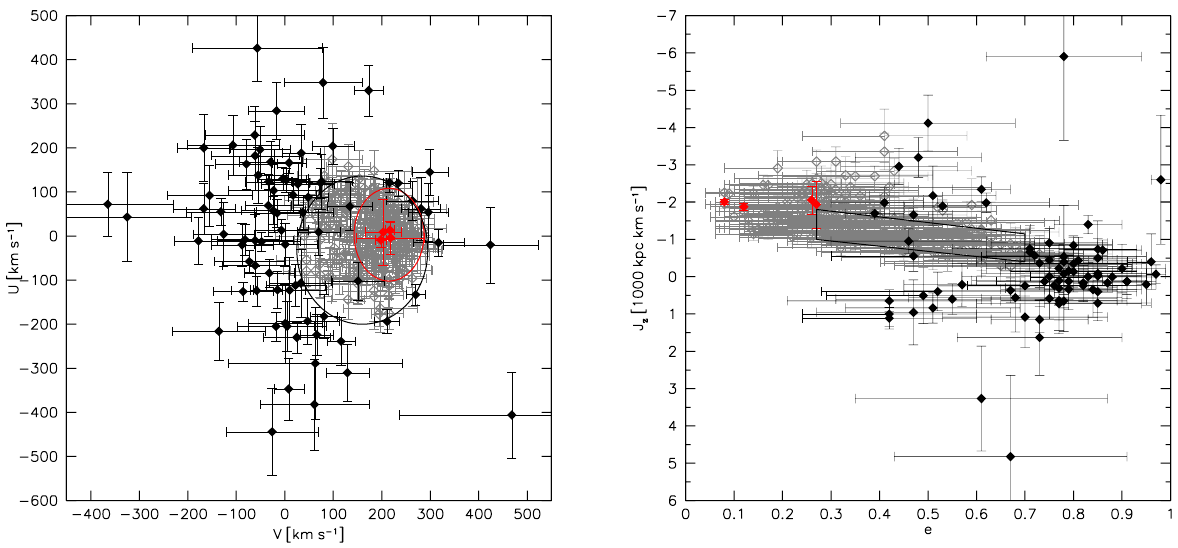
Figure 1. Left panel: U − V velocity diagram. Red filled diamonds mark thin disk stars, grey open diamonds thick disk stars, and black filled diamonds halo objects. The thin and thick disk regions from Pauli et al. (2006) are plotted as red and black ellipses. Right panel: J z − e diagram of the sample using the same colour coding of the symbols. The box marks the typical region, where thick disk stars are found (Region B, Pauli et al. 2006). Thin disk stars are found to the left of this